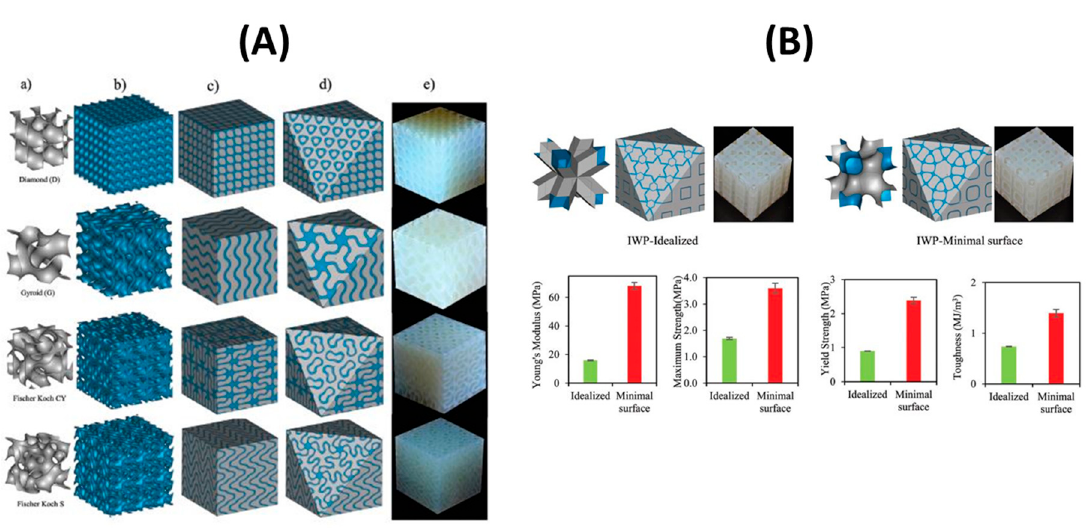
Figure 11. ( A ) Di ff erent TPMS topologies used as solid sheet reinforcement phases in IPC: (a) a single unit cell, (b) a 3 × 3 × 3 patterning of the TPMS, (c) the designed IPC, (d) a (111) plan cut to